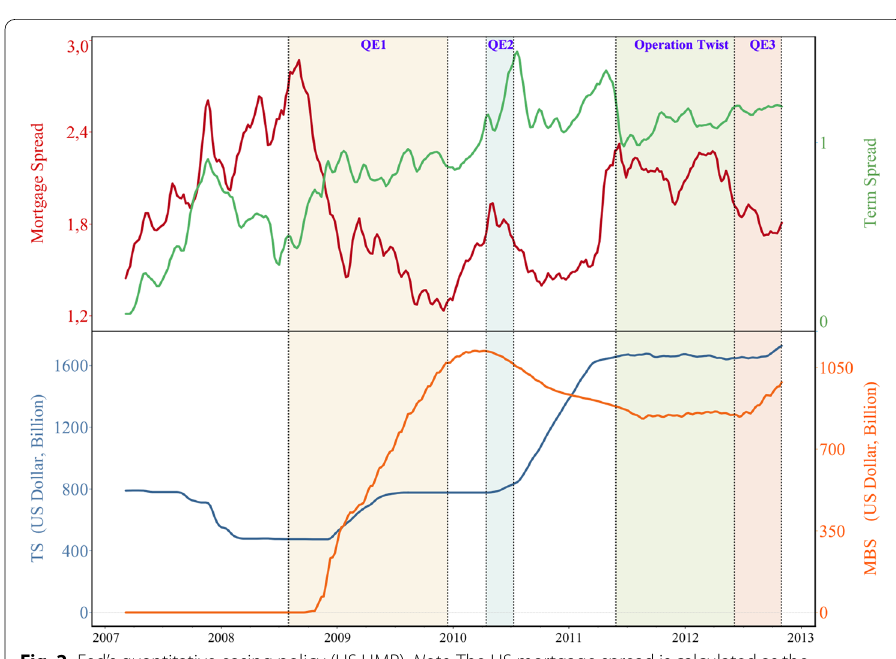
Fig. 2 Fed’s quantitative easing policy (US UMP). Note : The US mortgage spread is calculated as the difference between the 30-year fixed rate mortgage rate and 10-year Treasury bond rate. The US term spread is also defined as the difference between 30-year and 10-year Treasury yields. MBS and TS represent the Fed’s balance sheet holdings of MBS and TS, respectively. The QE1, QE2, operation twist, and QE3 span the periods, respectively: November 25, 2008 to April 11, 2010 (the QE1); August 10, 2010 to November 3, 2010(the QE2); September 21, 2011 to September 30, 2012(the operation twist); September 30, 20132 to February 24,